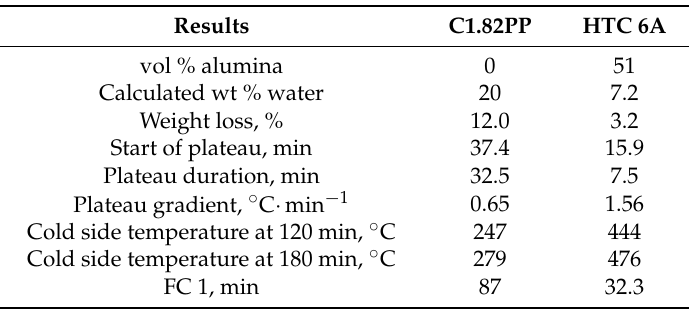
Table 4. Summary of fire test results.